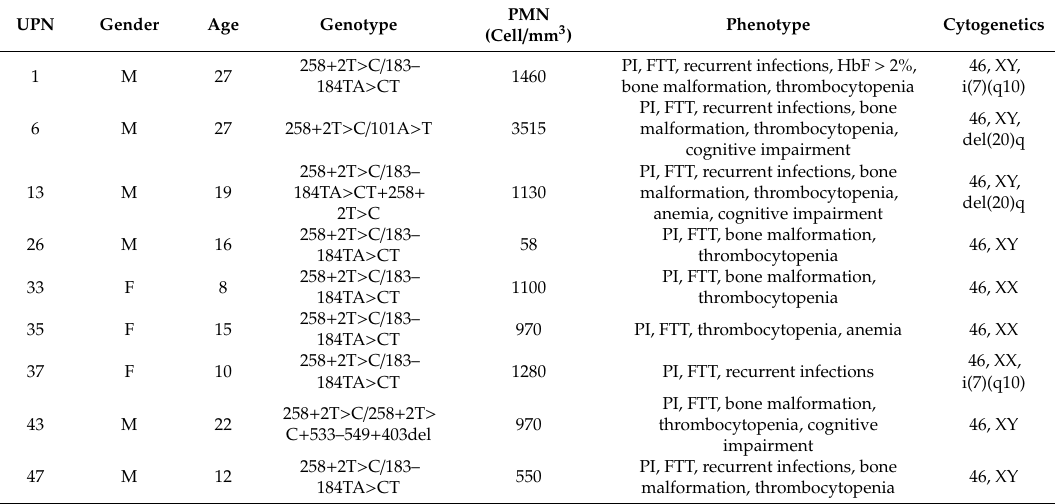
Table 1. Clinical data and genetics of patients with SDS recruited in this